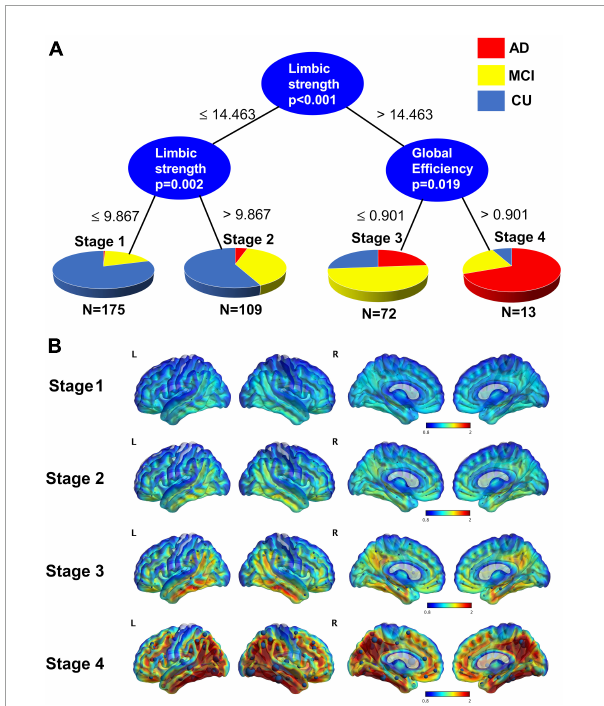
FIGURE6 (A) Conditional inference trees model for staging using limbic strength and global efficiency. A threshold of 14.463 for limbic strength separates those participants who are in stage 1 and 2 from those who are stage 3 and 4. Those lower than the 14.463 are further divided into stage 1 and stage 2 by the threshold 9.867. Those greater 14.463 are divided into stage 3 and stage 4 with threshold of global efficiency = 0.901. (B) Average tau surface maps for each stage. On top of the surface display, the average strength from each node are displayed. Stage 4 is particularly like the Braak